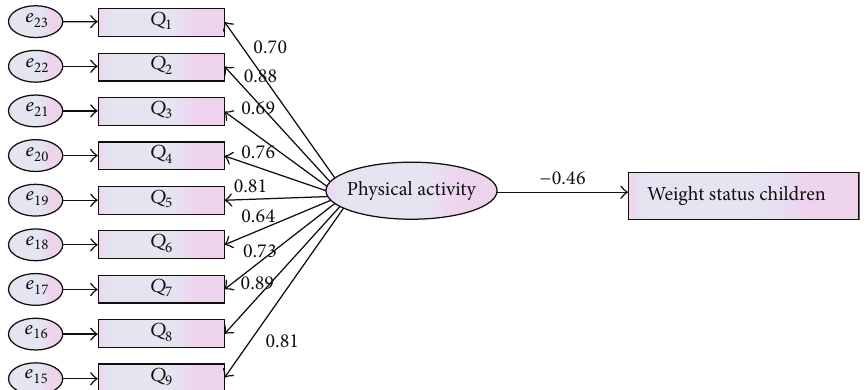
Figure 11: Standardized path coefficients and residual variance in the fifth